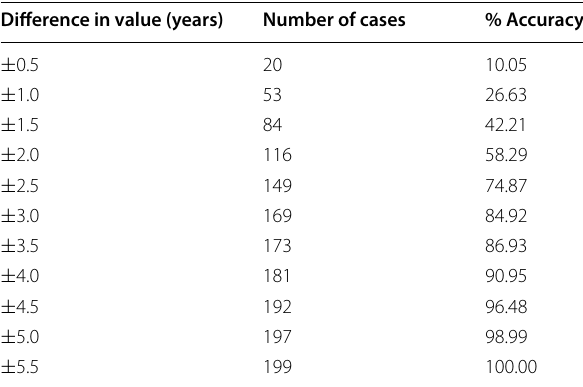
Table 3 Percentage of accuracy in age estimation of lower third molars in males and females within different values between estimated dental age in the proposed method and chronological age from 0.50 to 5.50 ± ±